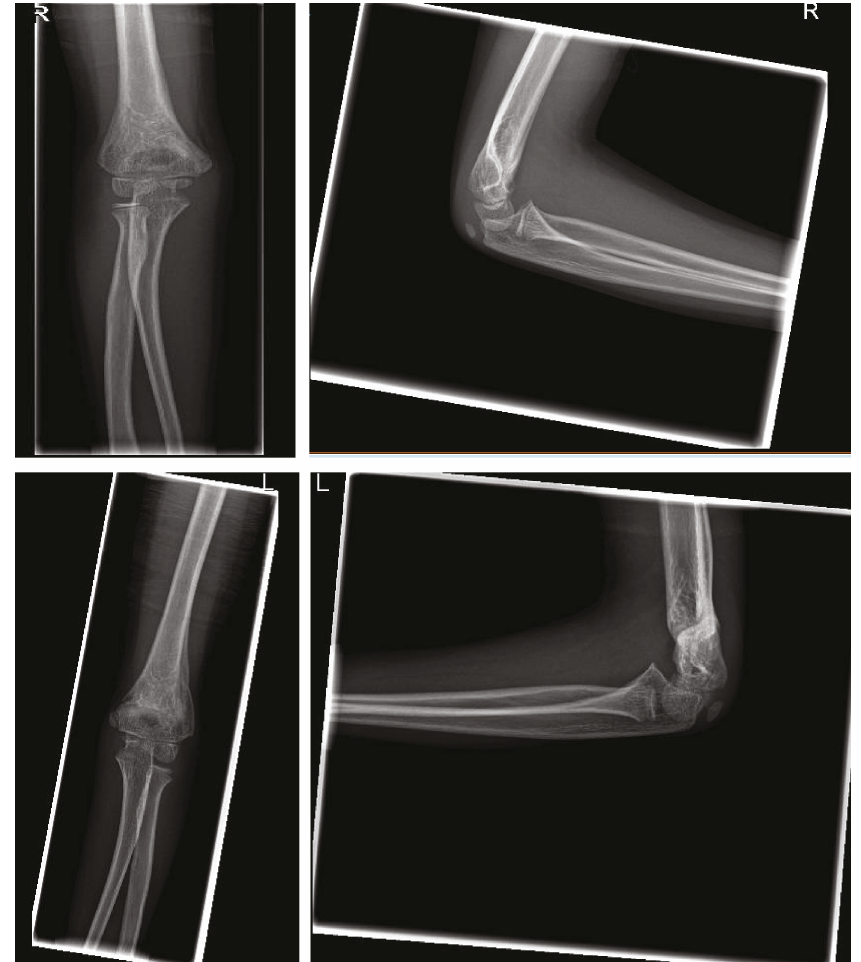
Figure 4: 6 months post-op X-rays. AP and lateral views of the right and left